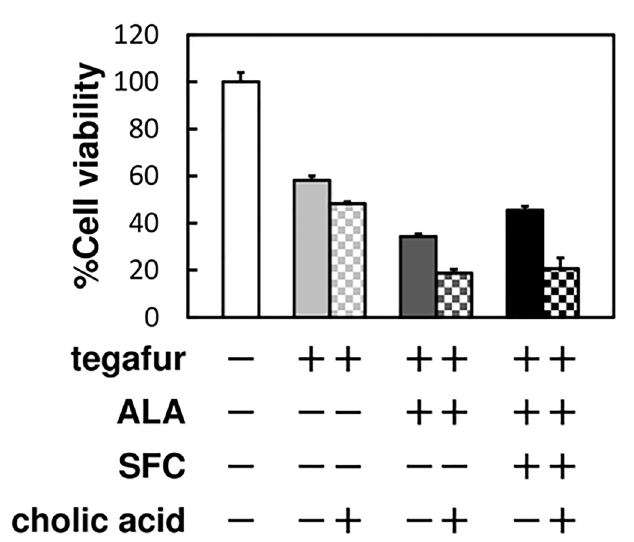
Fig 5. The effect of cholic acid on tegafur activation. Cells were incubated in culture medium containing 100 μ M cholic acid, 1.0 mM tegafur, 0.3 mM NADPH, 1.0 mM ALA and 0.5 mM SFC for 96 h and were subsequently analyzed for viability. Data are expressed as means ± S.D. in four independent